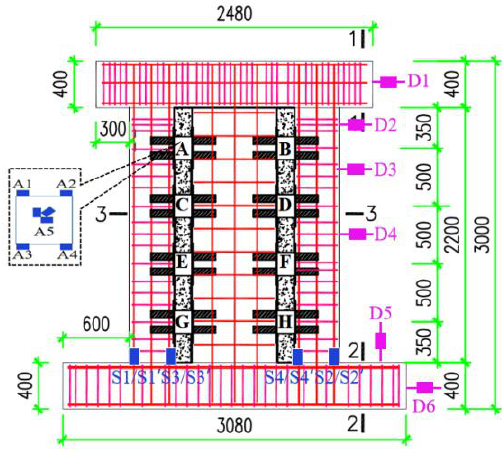
Figure 6. Arrangement of specimen ZP displacement meters and strain gauge; the displacement meters and steel strain gauge arrangement of specimen XJ were the same as for specimen